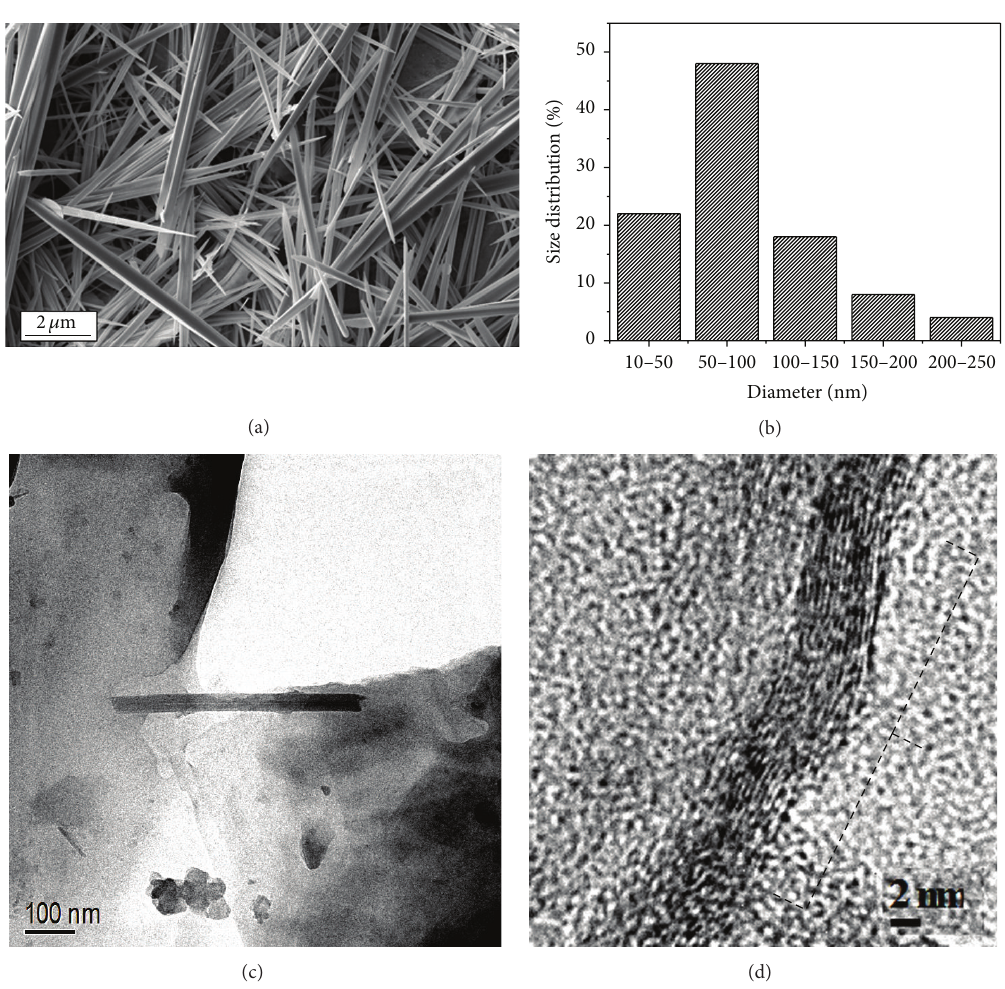
Figure 1: (a) FESEM image of wsCNRs with its size distribution histogram (b); (c) low-resolution TEM image showing the presence of single, straight wsCNR; (d) high-resolution TEM image showing the interlayer graphitic planes with a lot of surface defects (black